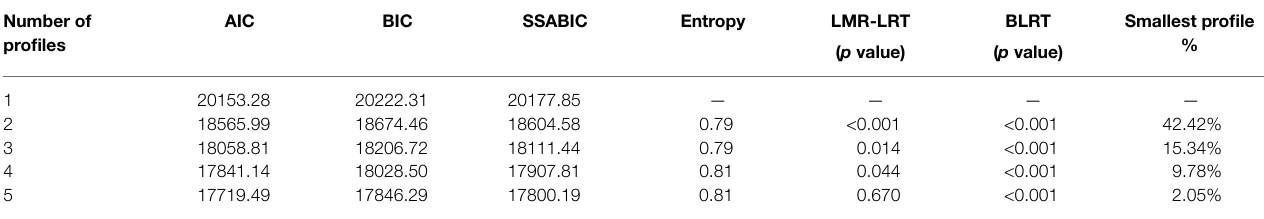
TABLE 4 | Summary of fit indices for one- to five-profile models. Number of AIC BIC profiles